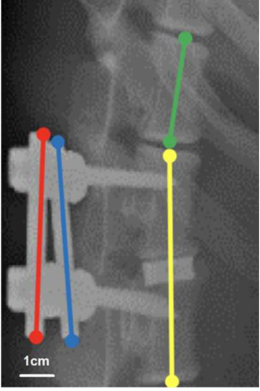
Figure 2. Assessment of fusion segment length. With a real connecting rod length of 5 cm, the sum of the measured length of the bilateral rods (red and blue line) divided by 2 is regarded as the measured connecting rod length, which should be 5 cm. For adjusting the bone growth of the vertebra, the vertebral growth ratio (VGR) is defined as the upper adjacent vertebral body length (green line) divided by the lower adjacent vertebral body length (yellow line) at a given time point on the day of the operation. The fusion segment length is defined as the length of the fusion vertebrae and interbody cage (yellow line) divided by the length of the measured connecting rod × 5 cm ×